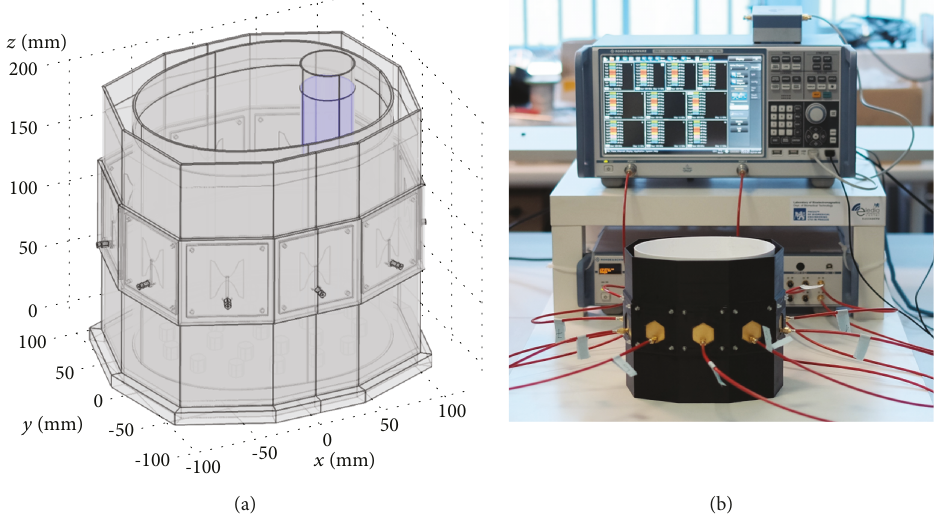
Figure 2: 3D model of measuring container with antennas and cylindrical phantom of stroke marked blue (a) and the photograph of the measuring setup